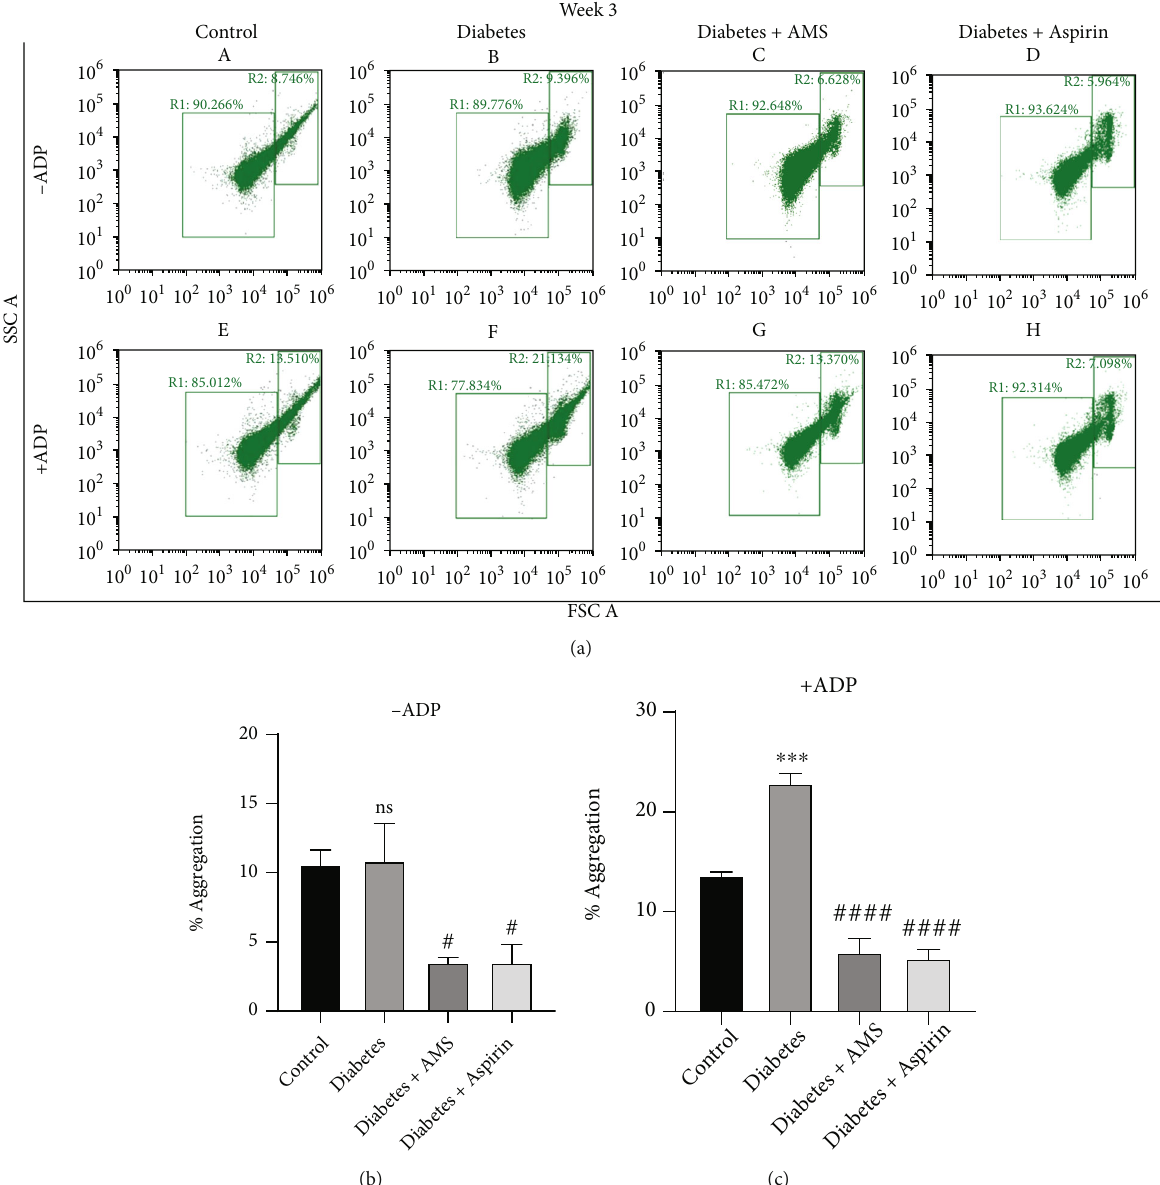
Figure 3: Flow cytometry analysis of platelet aggregation after 3-week treatment. (a) Scatter plot of forward vs. side scatter of platelets from the control (A, E), diabetic (B, F), AMS-treated diabetic (C, G), and aspirin-treated diabetic (D, H) groups, representing percentage of platelet aggregation in the absence and presence of ADP. Bar graph represents percentage of platelet aggregation observed in absence (b) and presence (c) of ADP. All values are represented as mean ± SEM ( N = 3 ). ∗∗∗ p < 0 : 001 vs. the control; # p < 0 : 05 , #### p < 0 : 0001 vs. diabetes; ns: nonsigni fi